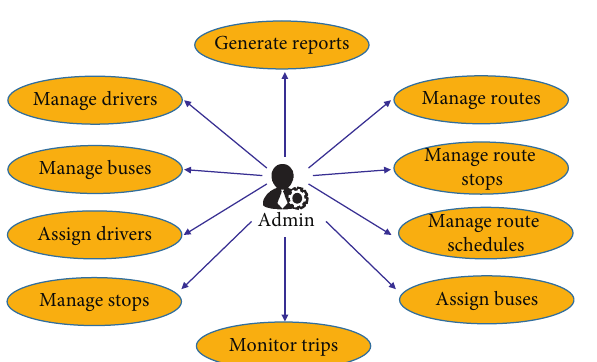
Figure 2: The use case diagram for the main features in the admin view.